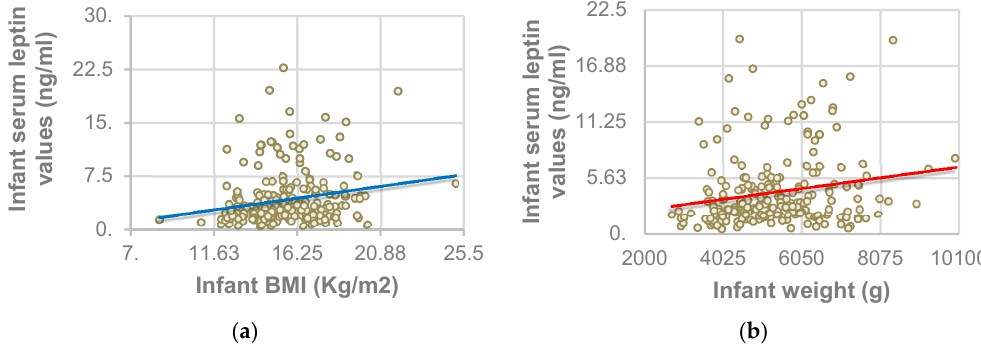
Figure 1. Correlation between infant serum leptin values and infant Body Mass Index (BMI) and weight. ( a ) Association between serum leptin values and BMI; ( b ) Association between serum leptin values and weight.